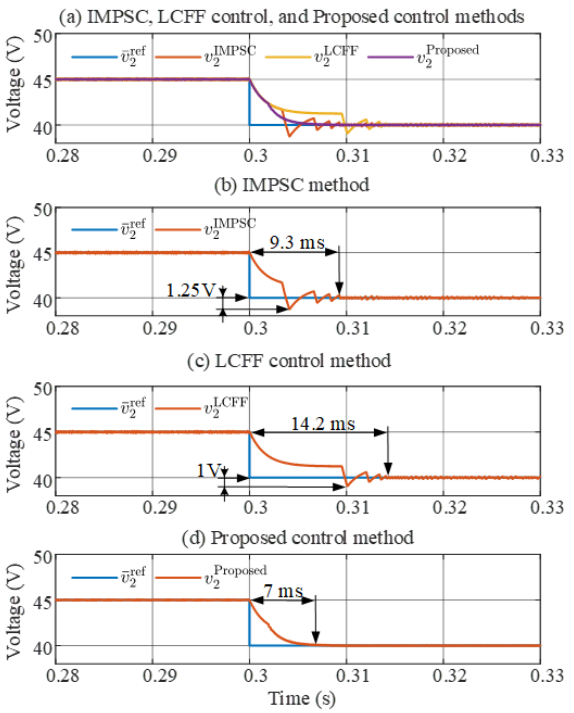
Figure 6. Simulation results of the output voltage when the reference steps down from 45 V to 40 V at t = 0.3